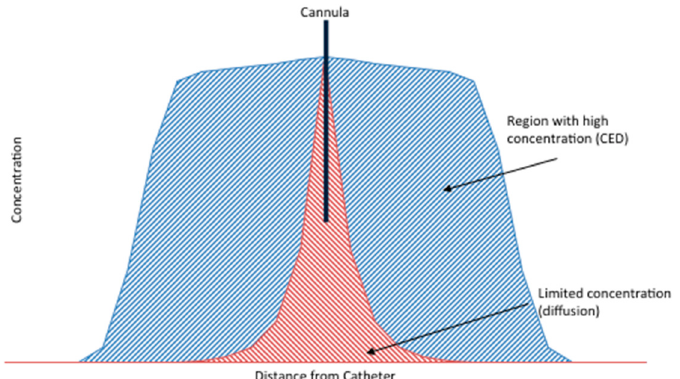
Figure 3. Graphic depiction comparing the distribution associated with diffusion away from a single point and “bulk flow”, based on a pressure gradient, as obtained in convection enhanced delivery (CED) of brain.